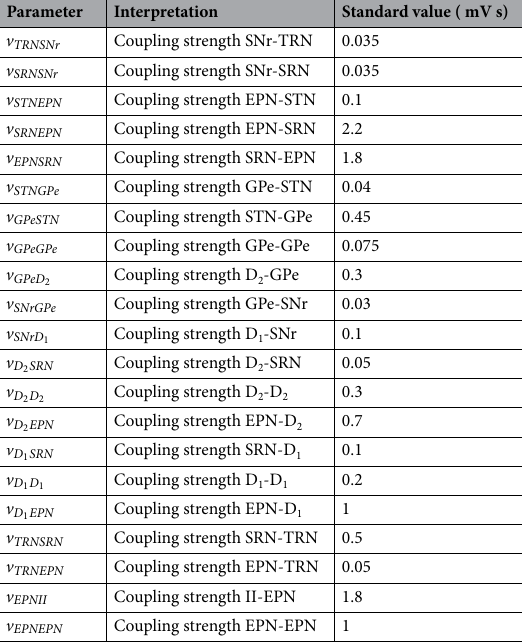
Table 1. Parameter interpretation.